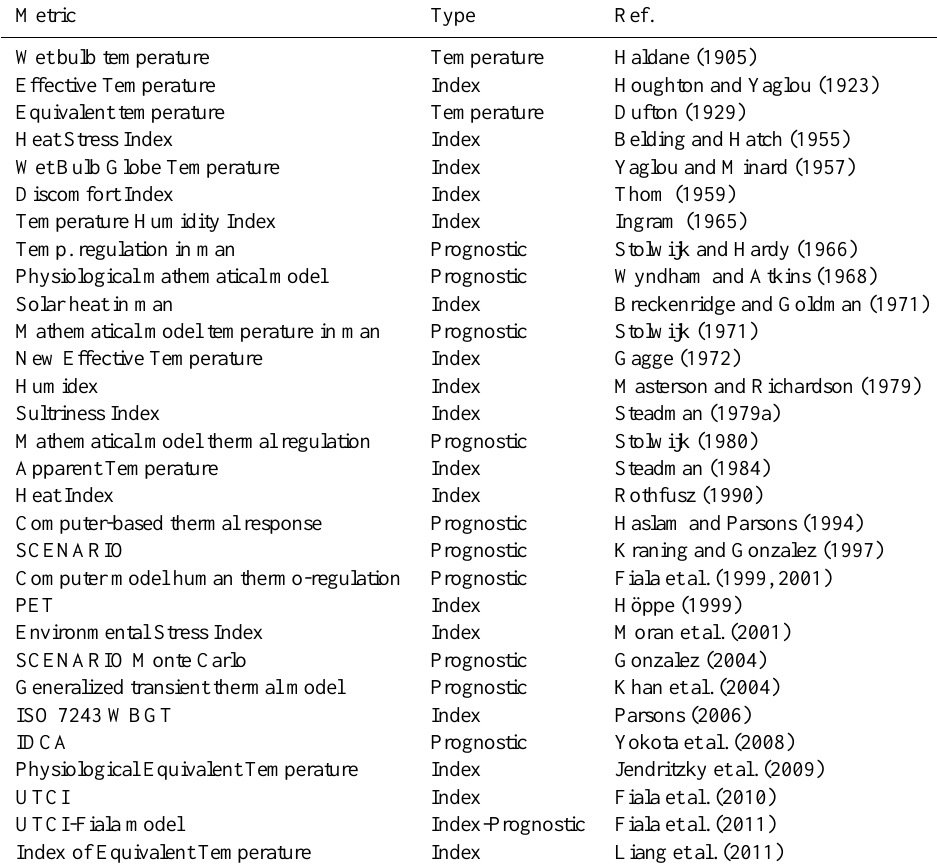
Table 1. Heat stress diagnostics and prognostic models.